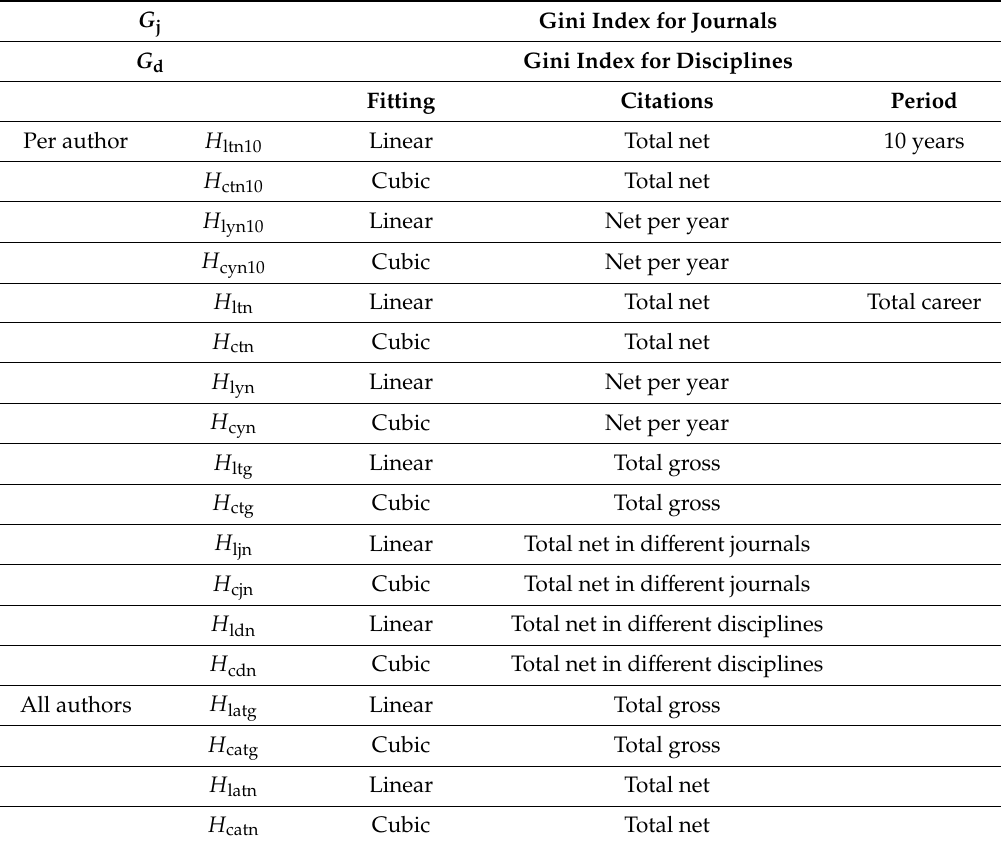
Table 1. Summary of notation applied in calculations. Definitions of abbreviations: cubic (c) fitting vs. linear (l) fitting; total (t) citations vs. per year (y) citations; gross (g) citations vs. net (n) citations; 10 years (10) vs. total career (no